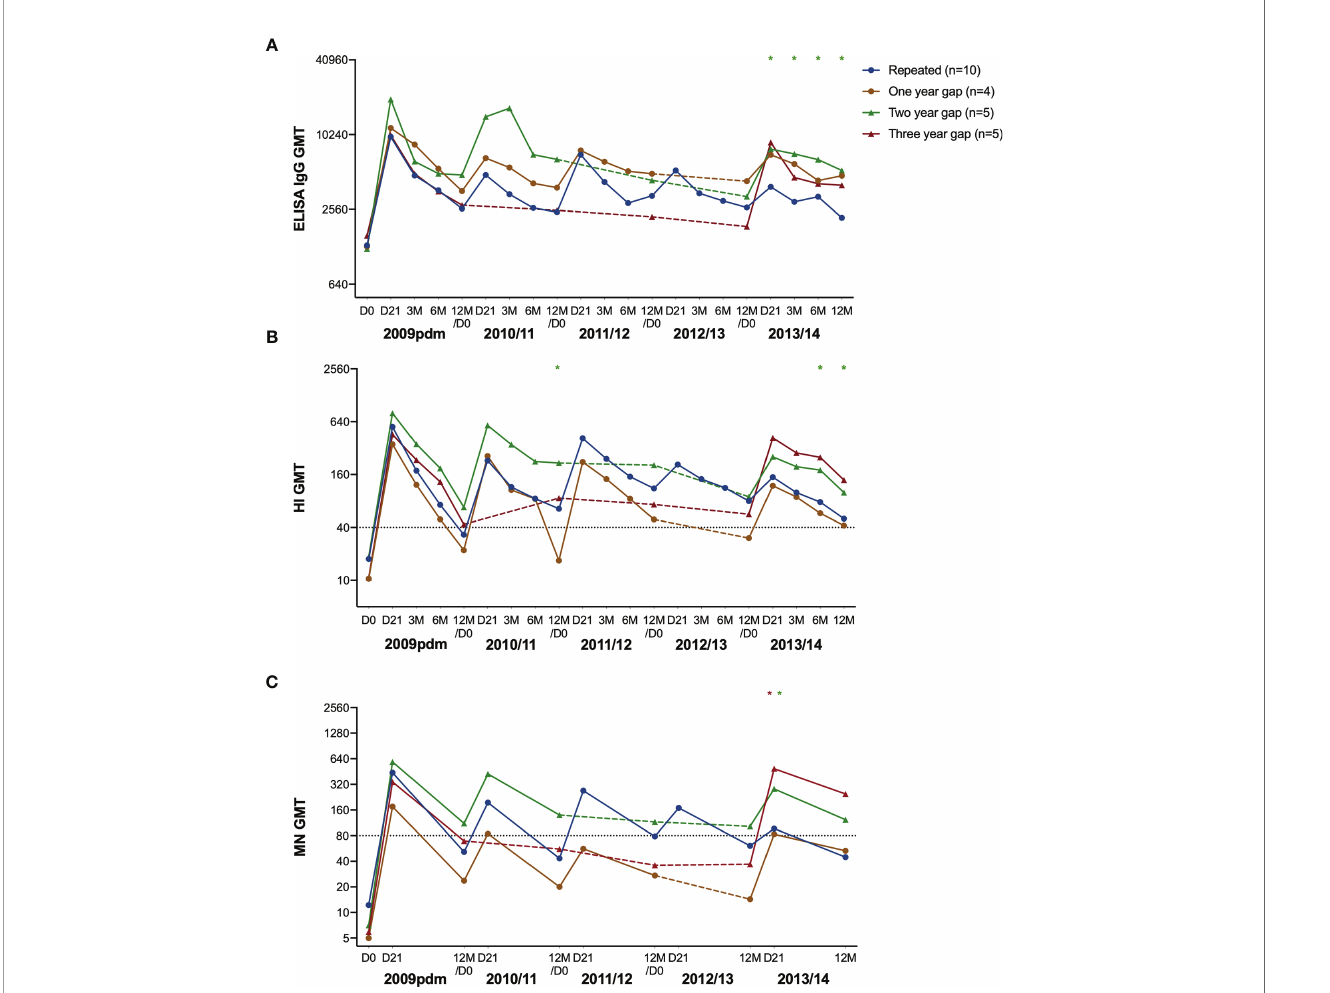
FIGURE 4 | The H1N1pdm09-speci fi c antibody response over fi ve years after pandemic and seasonal vaccinations. The geometric mean titre with 95% con fi dence interval measured in ELISA (A) , HI (B) , and MN (C) in repeatedly vaccinated HCW, and HCW with a one-, two- and three-year gap in vaccinations before vaccination in 2013/14. The titres at pre-vaccination (D0), and at 21 days (D21), 3, 6, and 12 months after vaccination are shown. The gap-years without vaccination is illustrated with a dotted line. The data was log-transformed and compared between groups with linear mixed-effect models, with Dunnett ’ s test for multiple comparisons. The repeatedly vaccinated HCW was used as the reference group. ***P < 0.001, **P < 0.01, *P <